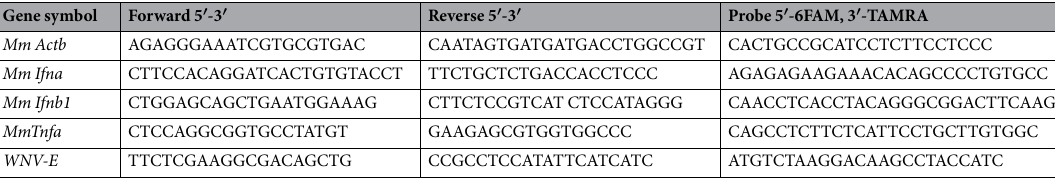
Table 1. Primers and